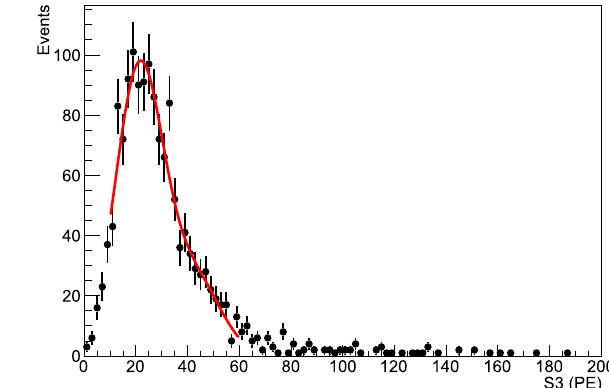
Right: S3 charge distribution for events in which the delay between S2 and S3 signals is within ( T max ± 4 ) µ s, superimposed with the fit = 183 V/cm. described in the d